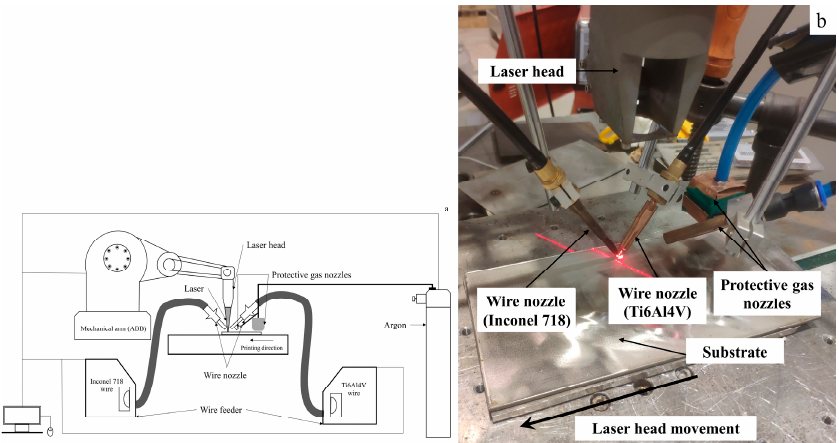
Figure 1. A picture of the experimental set-up ( a ) Schematic diagram of platform equipment; ( b ) Laser equipment operation diagram. Table 1. Chemical composition of the Ti6Al4V alloy wire (mass fraction, %).